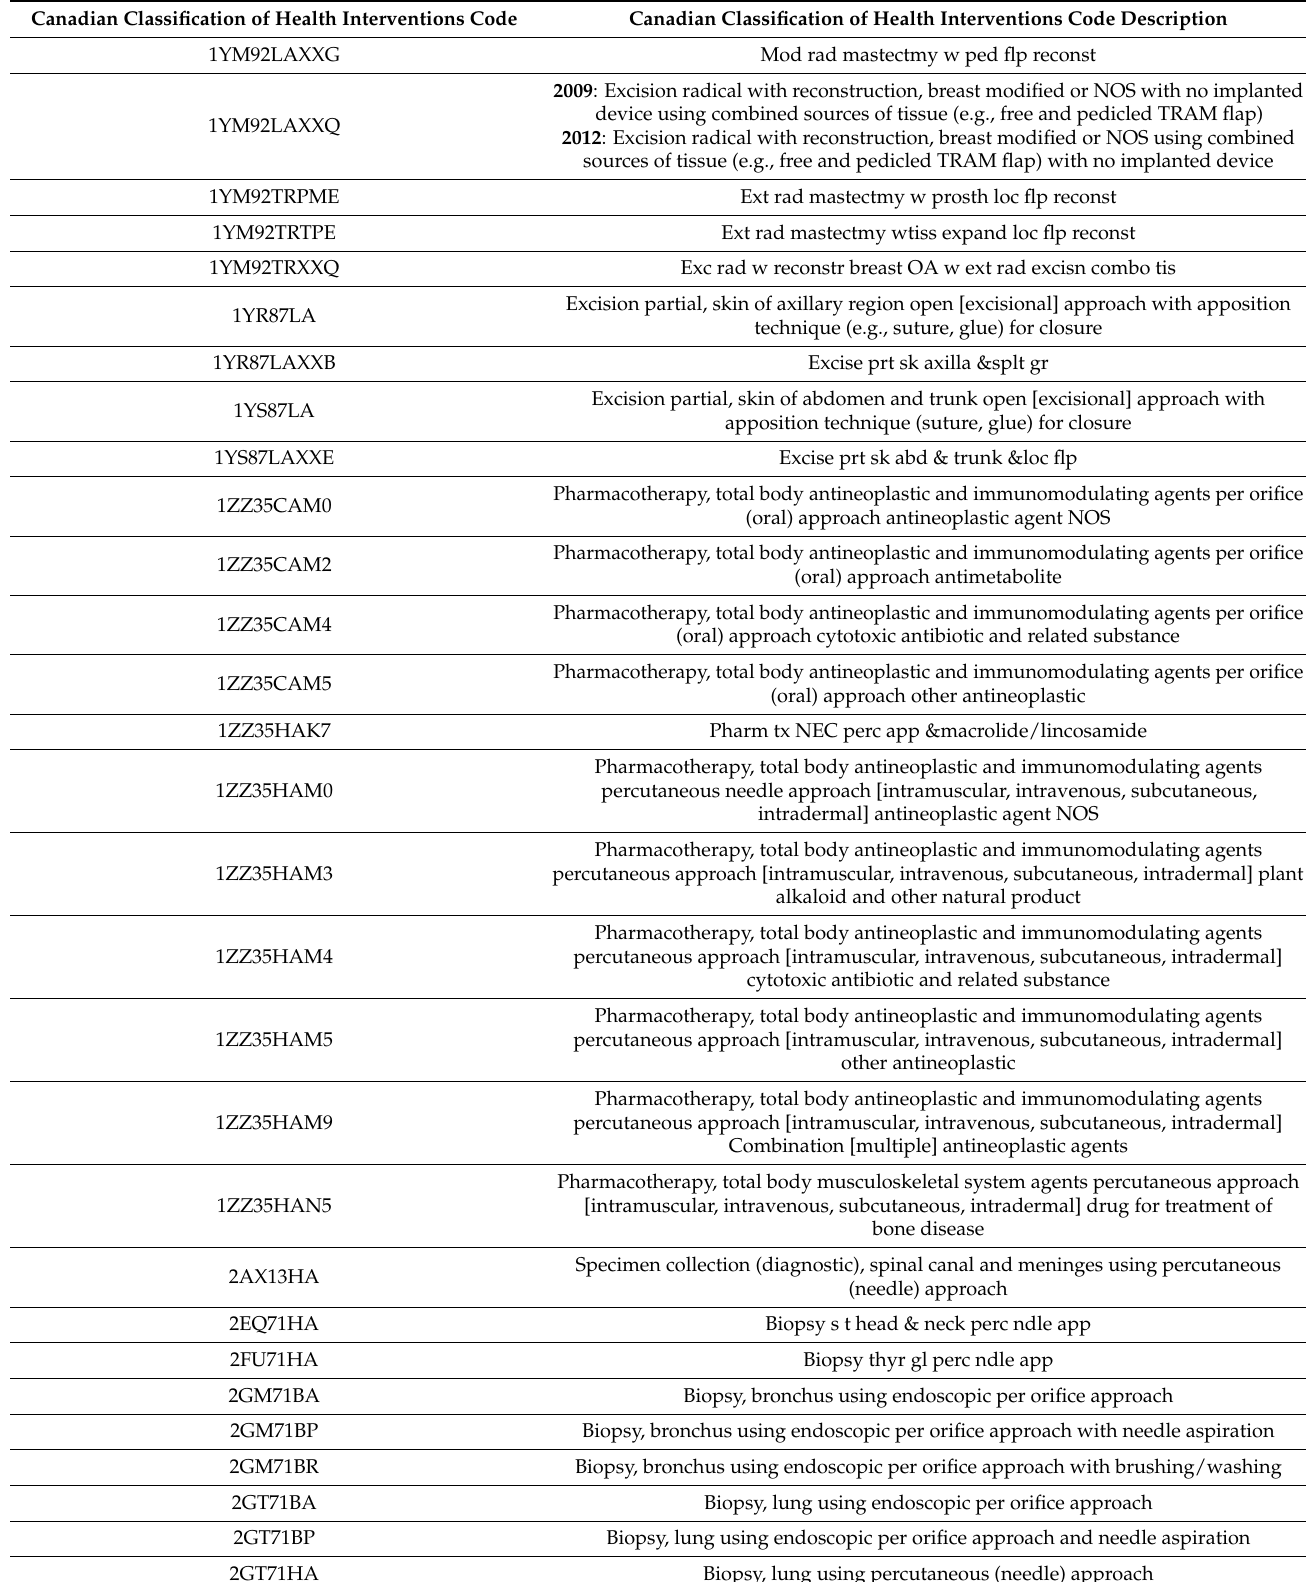
Table A2. Cont. Canadian Classification of Health Interventions Code Canadian Classification of Health Interventions Code